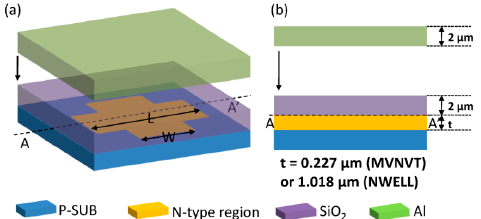
Figure 1. Schematics of the three-dimensional view ( a ) and sectional view ( b ) of the designed structures of Hall devices. L and W are the length and width of Hall device. S2 and S4 are covered by an aluminum layer, but S1 and S3 are not. The N-type region of both S1 and S2 is NWELL and S3 and S4 use MVNVT as the N-type region.